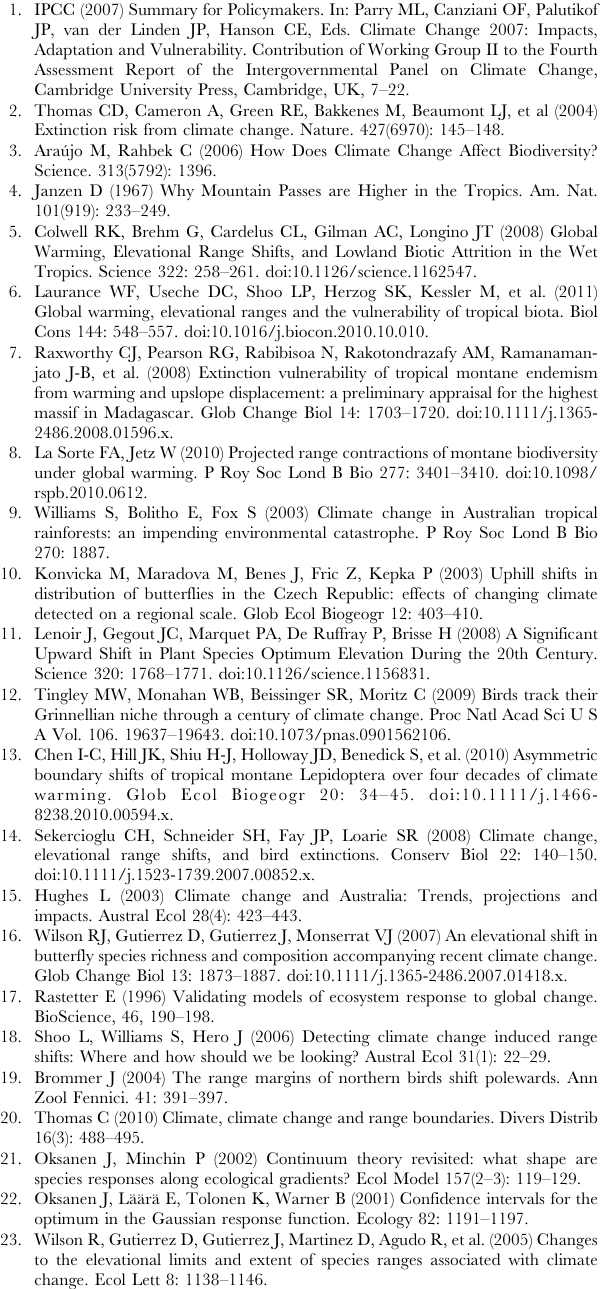
Table S1 AIC scores for competing models in HOF [ 30 ] analysis. Shown are competing models in a hierarchical Huissman-Olff-Frescoe [30] model selection analysis for eleva- tional density responses across the 88 Australian Wet Tropics rainforest bird species (those with sufficient sampling in this study). Models were selected using the approach implemented in the R package ‘‘BiodiversityR’’ (Kindt 2011) (see methods for